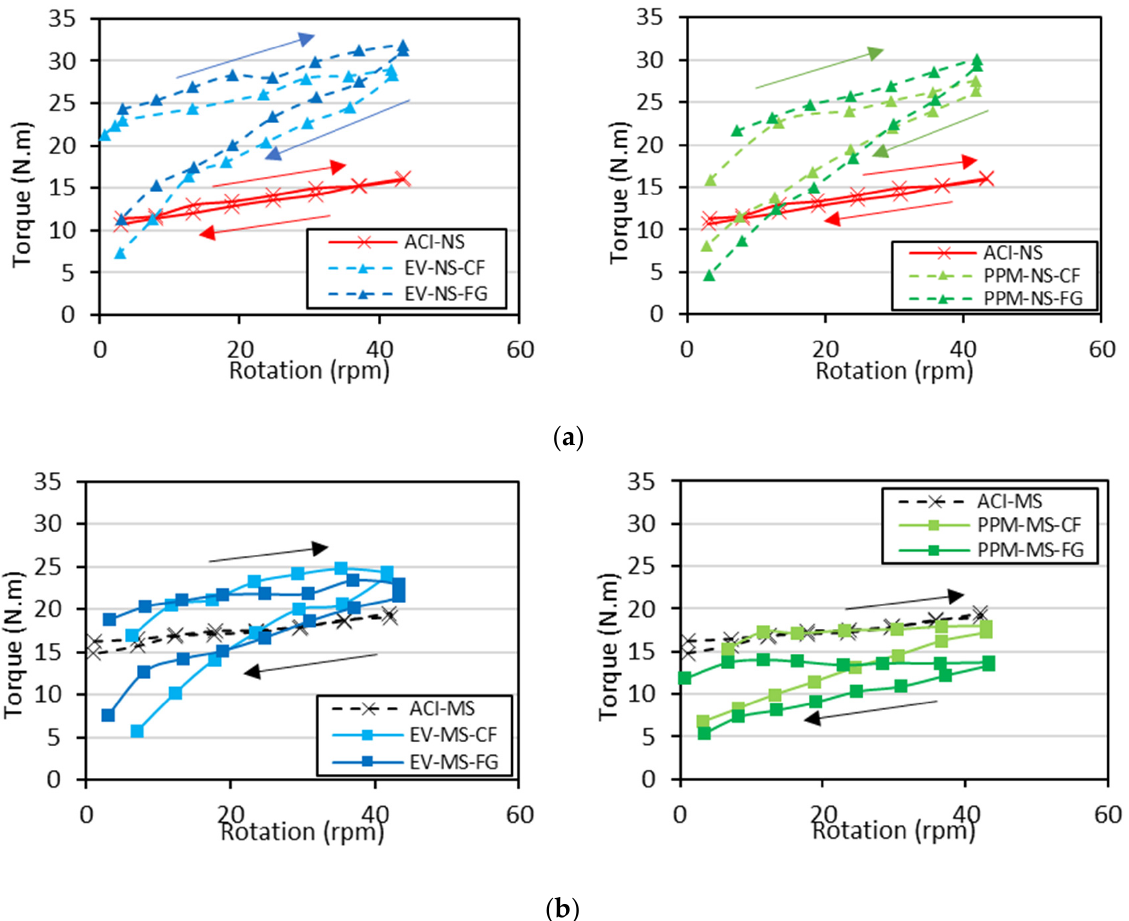
Figure 6. Rheological profiles of concrete mixtures made of NS ( a ) or MS ( b ). Analyzing the plots, one first verifies that all mixtures yielded a shear-thinning be- haviour, i.e., decrease in viscosity (slope of the torque vs. rotation curve) as a function of the torque applied regardless of the mix design procedure adopted. Second, the PPM mixtures displayed the lowest yield stress, i.e., requiring a lower amount of torque to enable flow (i.e., 4.74 N.m to 8.17 N.m), followed by EV (7.32 N.m to 11.33 N.m) and ACI (10.70